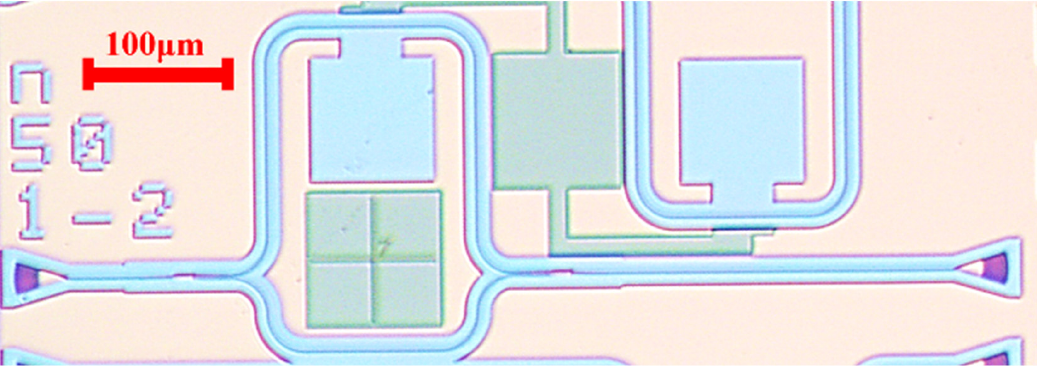
Figure 4. Microscopic image of the temperature sensor based on AMZI.